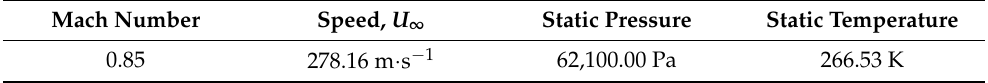
Table 1. Free-stream